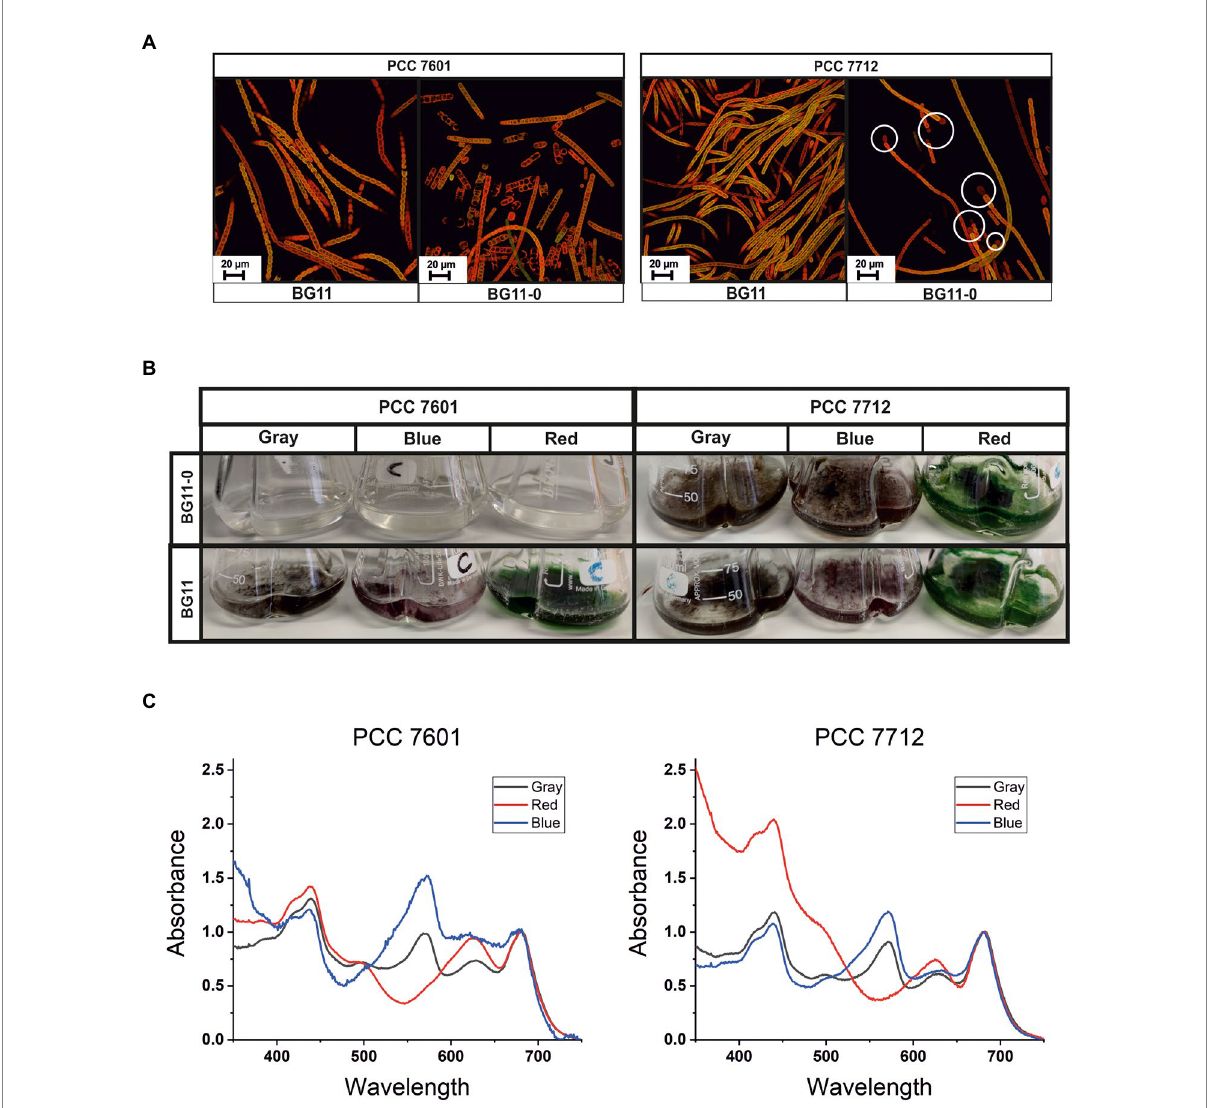
FIGURE 4 (A) CLSM images of PCC 7601 and PCC 7712 cultures growing in BG11-0 or BG11 media; white circles indicate heterocyst cells, which are less fluorescent as they lack pigmentation. (B) Cultures growing in different light spectra in shake flasks in either BG11-0 or BG11. (C) Chromatic light adaptation. Whole-cell absorption spectra of cultures covered with different colored foils—red, blue, and